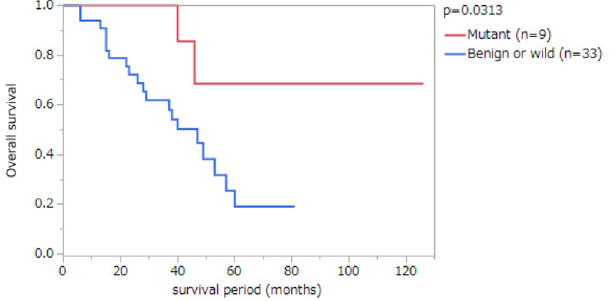
Figure 3. Kaplan-Meier survival analyses of patients with pancreatic ductal adenocarcinomas (PDACs) according to mutations in the BRCA pathway genes. Nine patients with PDACs with potentially deleterious mutations in BRCA pathway genes, namely, BRCA1 , BRCA2 and PALB2 (Mutant), and 33 patients with PDACs with benign mutations or without mutations in the BRCA pathway genes (Benign or wild) were compared. The P value was obtained by Log-rank